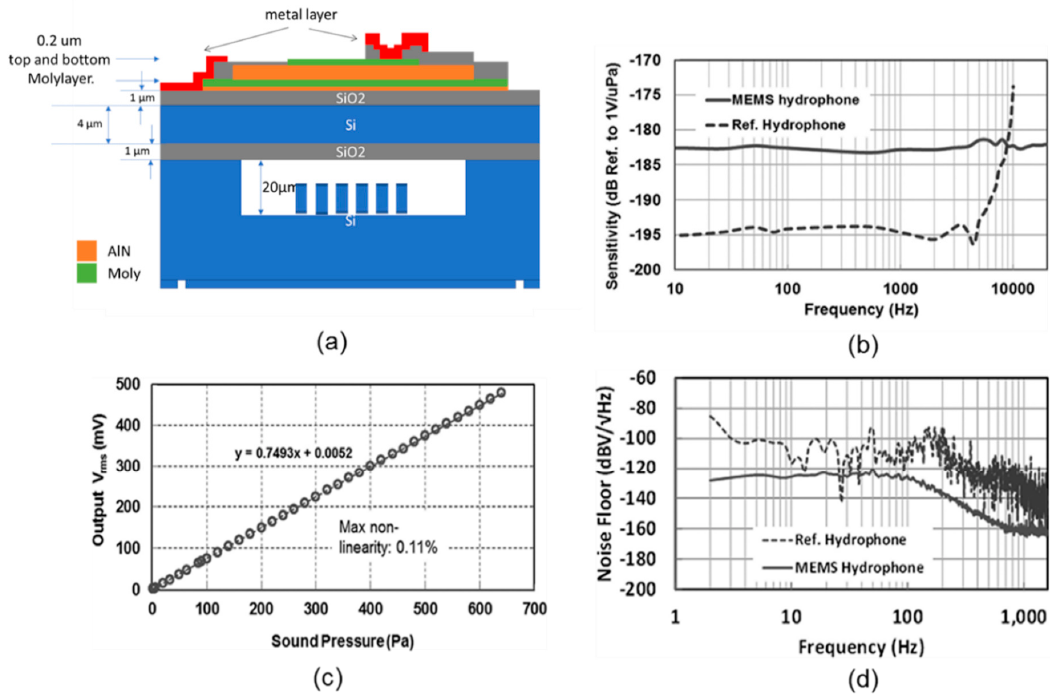
Figure 1. Piezoelectric AlN-based micro-machined infrasonic hydrophone sensor. ( a ) Cross-sectional view. ( b ) Hydrophone acoustic measurement. ( c ) Non-linearity measurement obtained by sweeping the sound pressure up to 640 Pa at 26 Hz. ( d ) Measured noise performance.